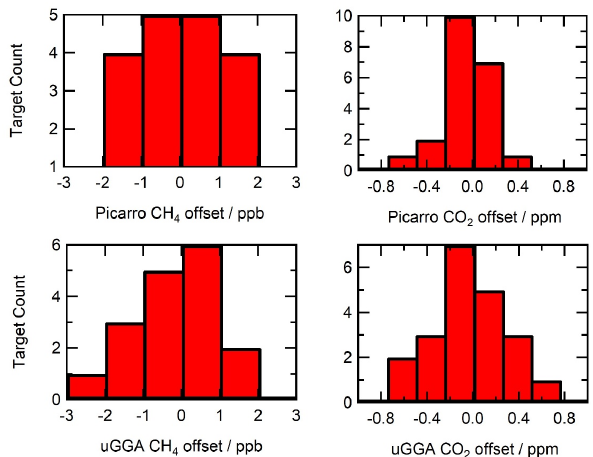
Figure A4. Target gas data from flights during 2018 for the Picarro G2311-f and Los Gatos uGGA instruments for both CO 2 and CH 4